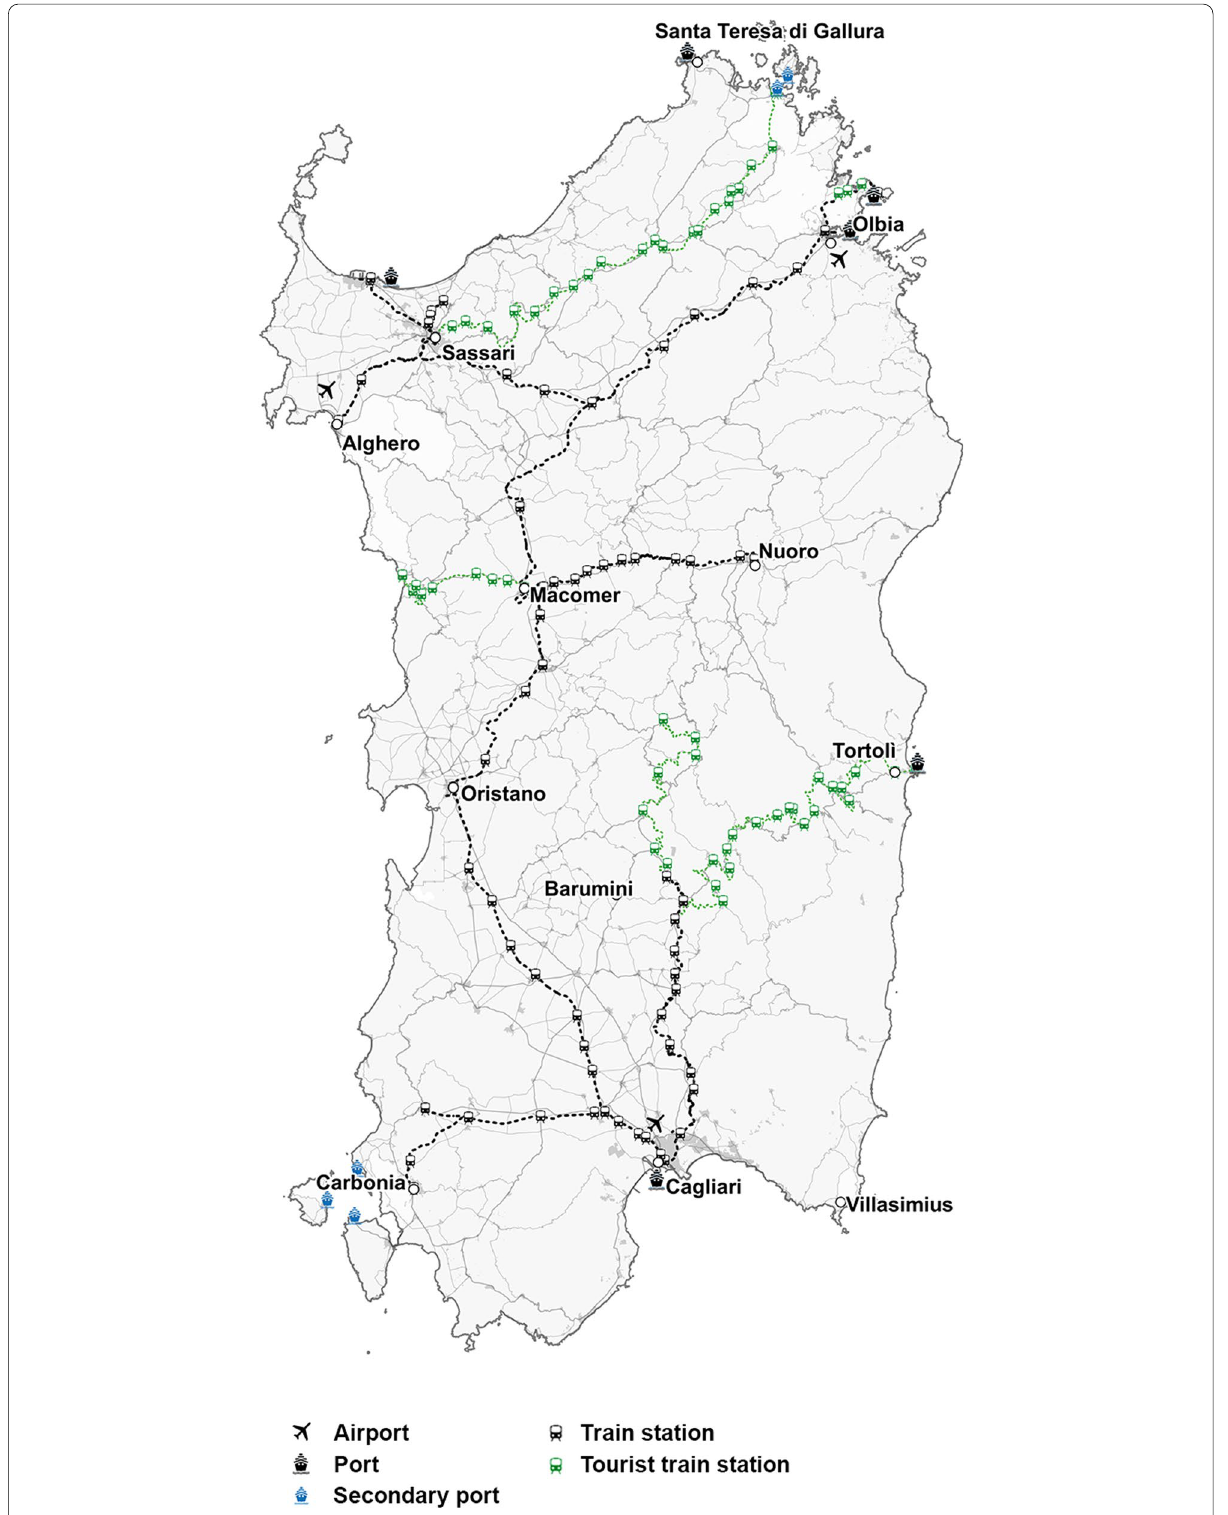
Fig. 4 Intermodal